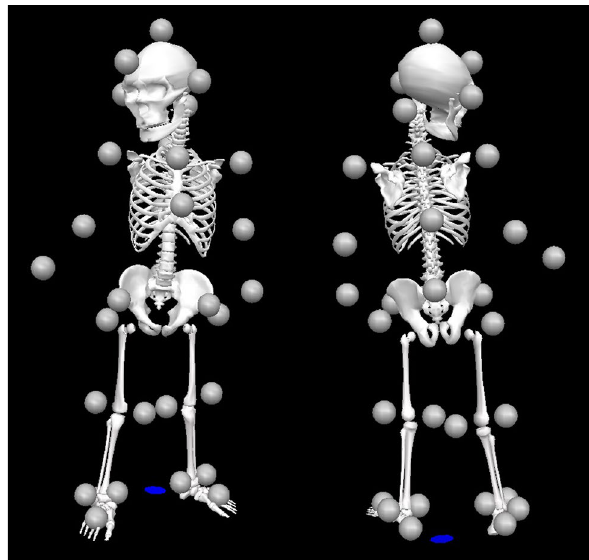
Figure 4. Nine-segmented body model constructed from 32 markers.